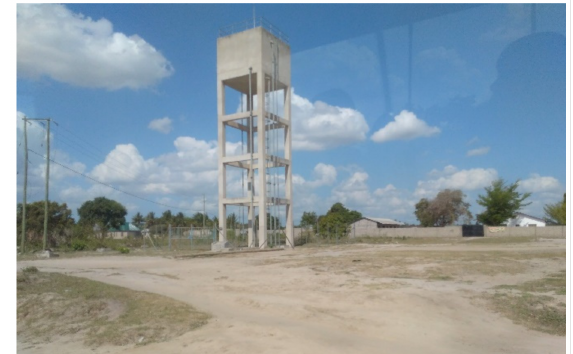
Figure 2. Example of an elevated water storage tank as a water supply system (photo: Saskia Wolff 2017).